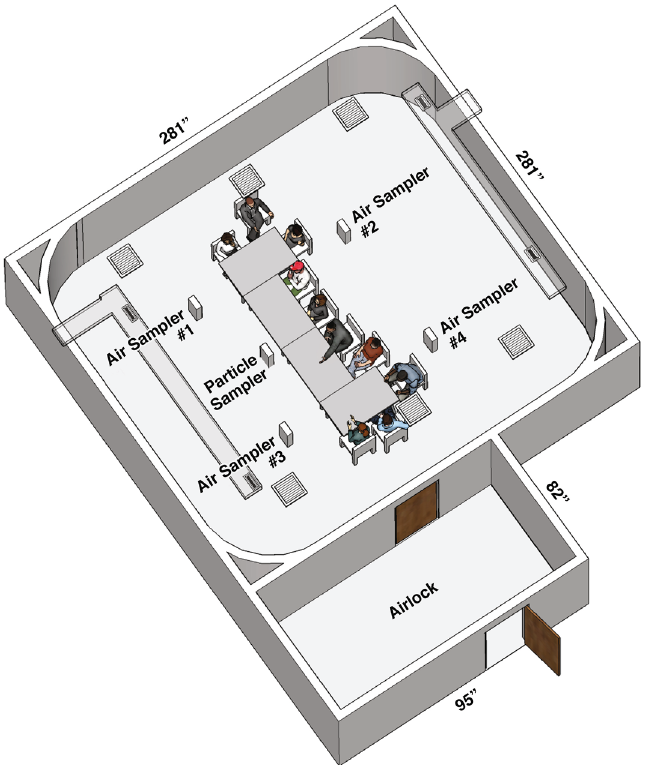
Figure 5. Exposure Chamber and Airlock showing air and particle sampler